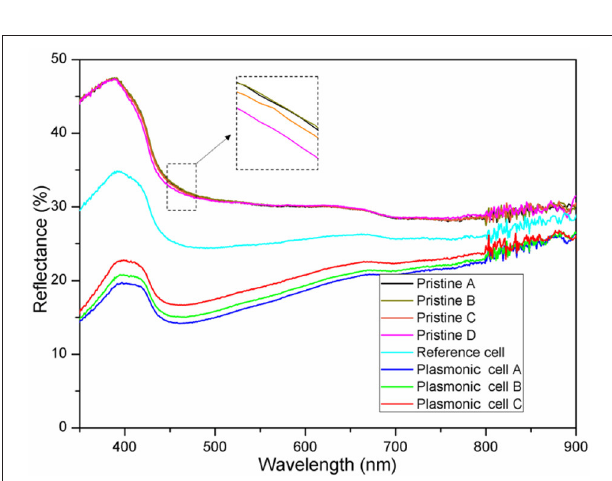
FIGURE 5 | Optical reflectance spectra of the pristine cells A-D, plasmonic cell A-C and pristine cell D decorated with pure